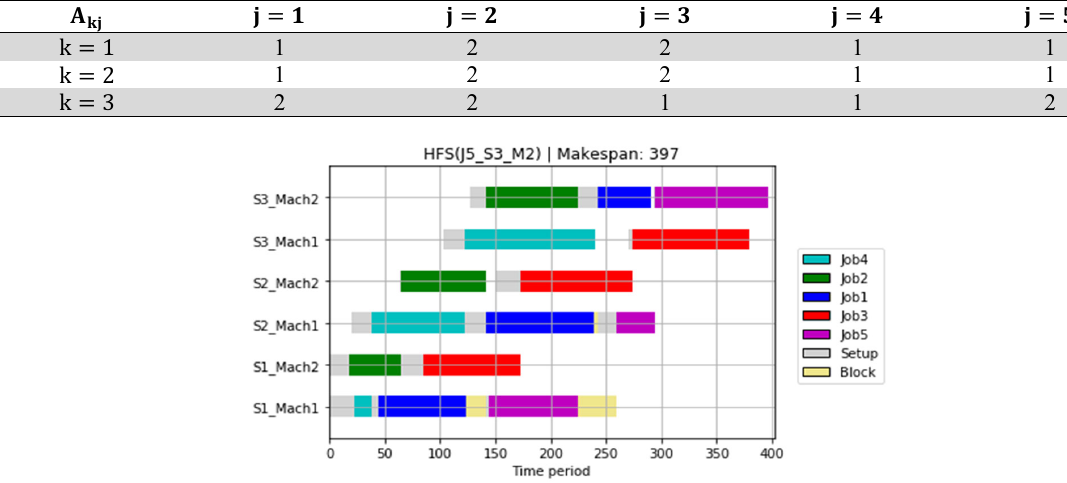
Job allocation per production stage for the presented example